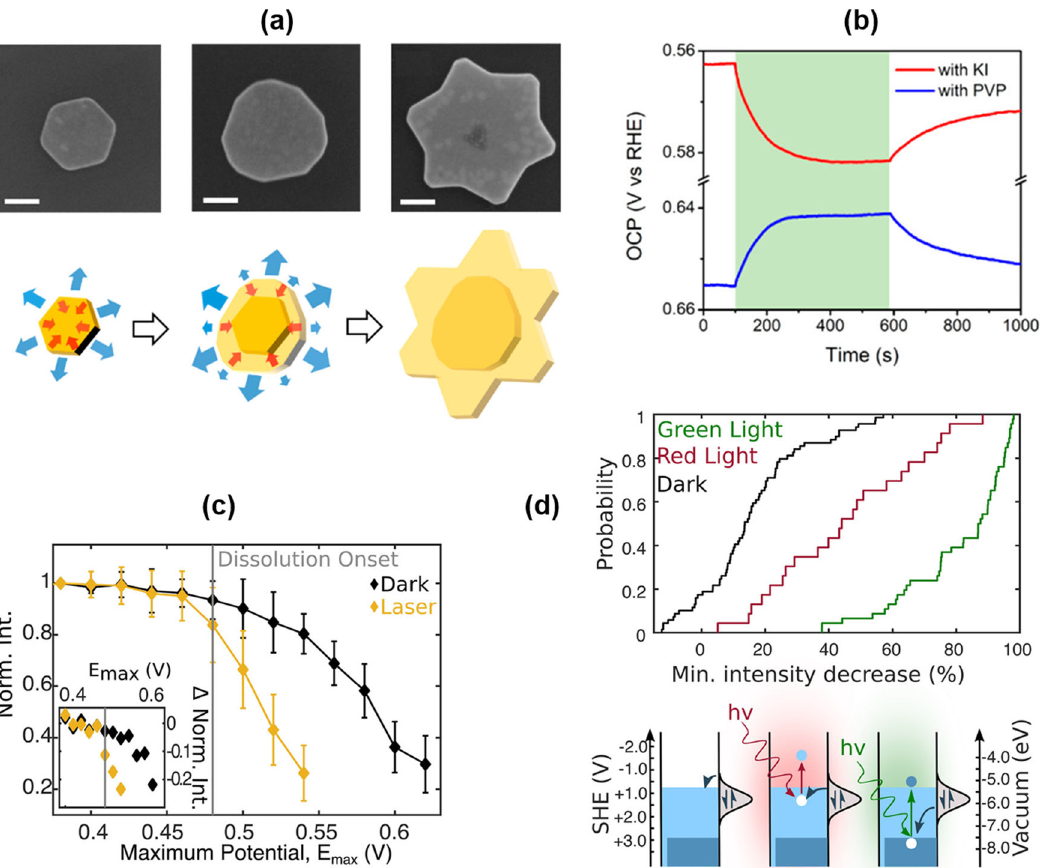
Fig. 9 Plasmon-assisted growth and dissolution of nanoparticles. a Plasmon-driven structure evolution of Au nanoparticle. The hot-electron-driven deposition of Au(0) results in gradual growth (blue arrows), and hot-hole-driven preferential etching results in truncation (blue arrows). b Open circuit potential (OCP) measurement of Au nanoparticle in the presence of KI and PVP, respectively (shaded area represents light irradiation). The anodic change in the presence of iodide suggests hot holes trapping by surface Au-iodide species. In contrast, the cathodic change in the presence of PVP represents the trapping of hot electrons by PVP ( a , b reprinted with permission from ref. 14 copyright © 2020, American Chemical Society). c , d Hot-hole-assisted oxidative electrodissolution of Au nanorod. c Dissolution onset potential in the presence and absence of light monitored following the normalized average scattering intensity. d Depending upon the excitation wavelength of light, the hot carrier energy distribution changes. The energetic hot holes from the d -band (with green light) can cause faster dissolution (resulting in scattering intensity decrease) than the holes near the Fermi level ( c , d reprinted with permission from ref. 31 Copyright © 2019, American Chemical (Fig. 10b) 13 . The wavelength-dependent excitation of AuNPs